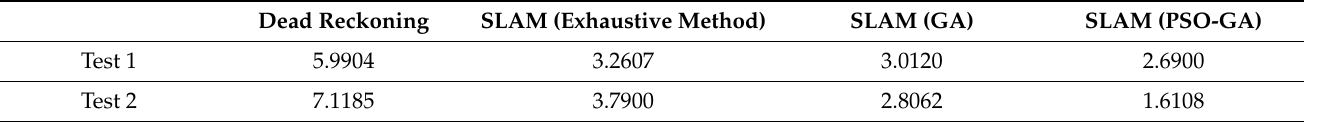
Table 1. RMSE of the position under different algorithms; unit: m.